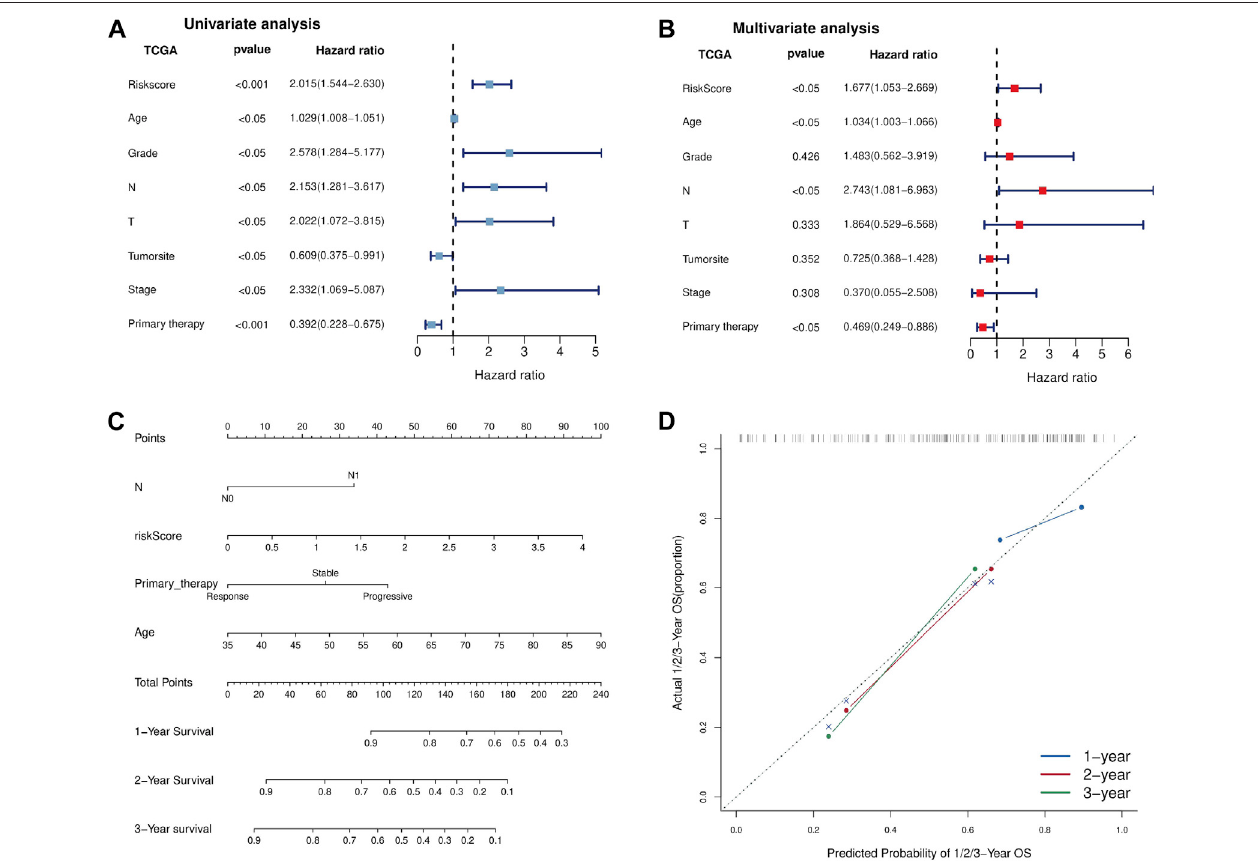
FIGURE7| UnivariateandmultivariateCoxanalyseswereperformedbasedonriskscoresandotherclinicalfeaturesintheTCGAdataset (A,B) .Anomogramwas constructed based on pathological T stage, risk score, primary therapy outcome and age in the TCGA cohort (C) . A calibration plot con fi rmed the robustness of the Fe- LPM (D)